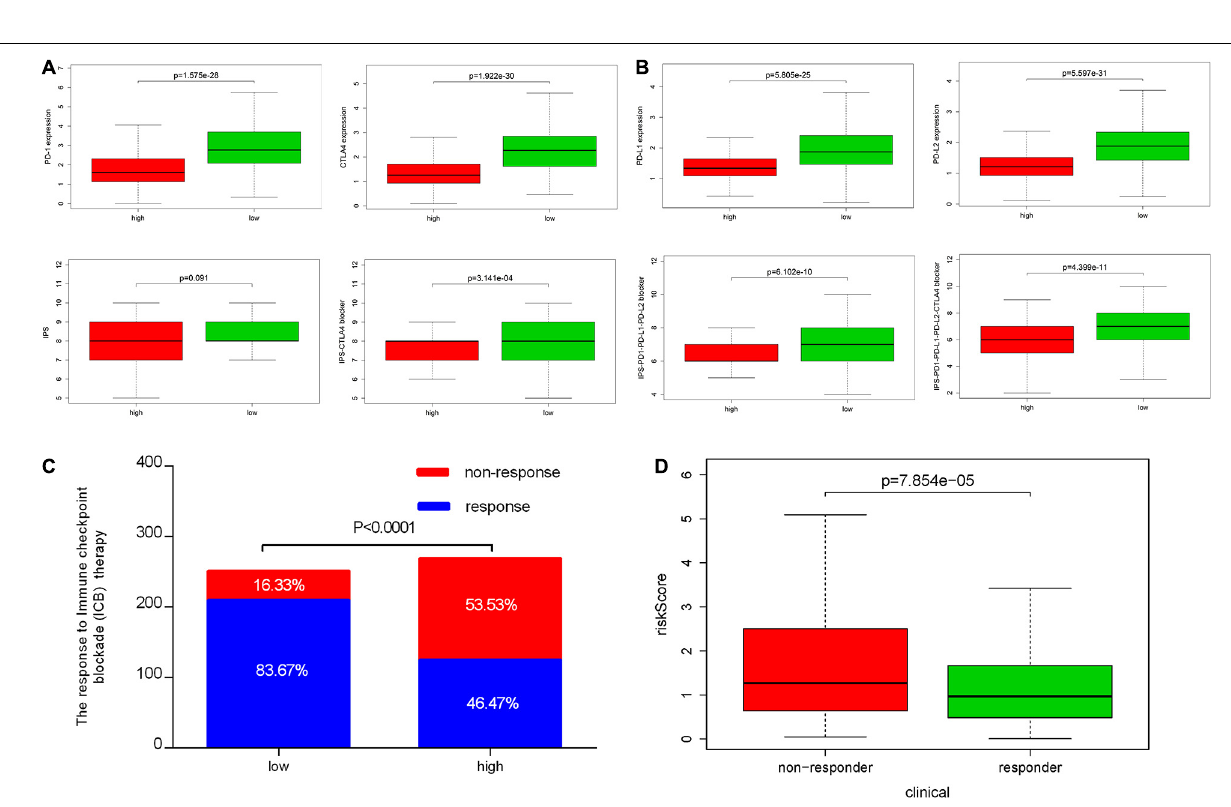
Frontiers in Cell and Developmental Biology |